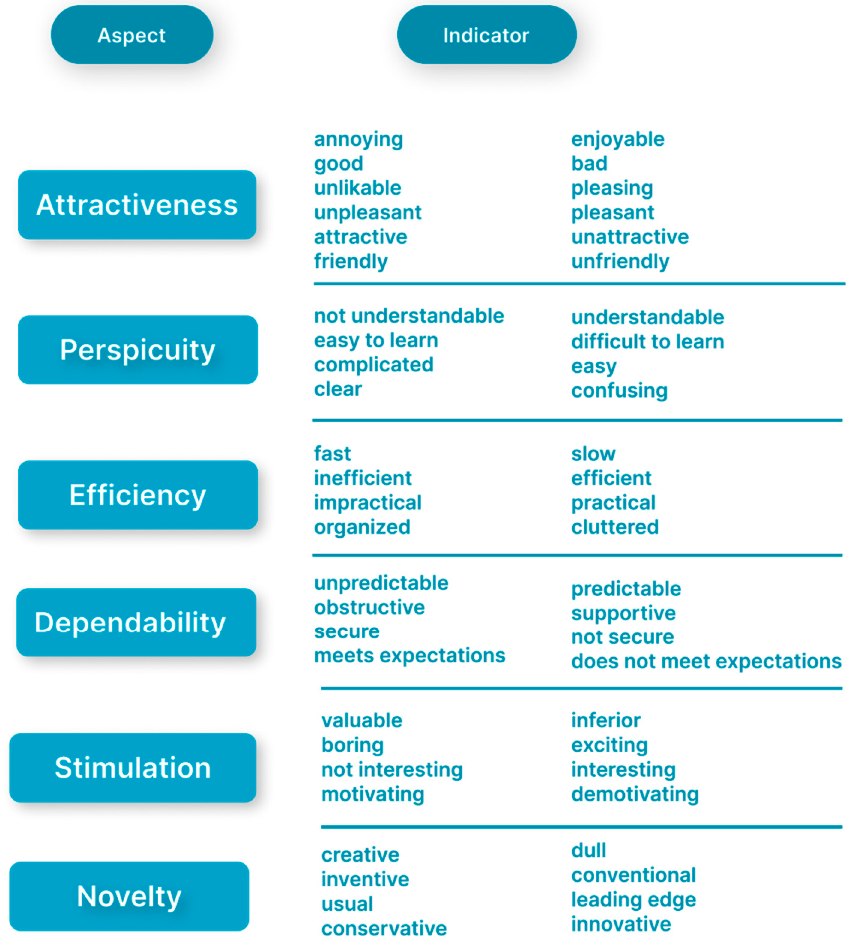
Figure 3. The indicators of user experience questionnaire.